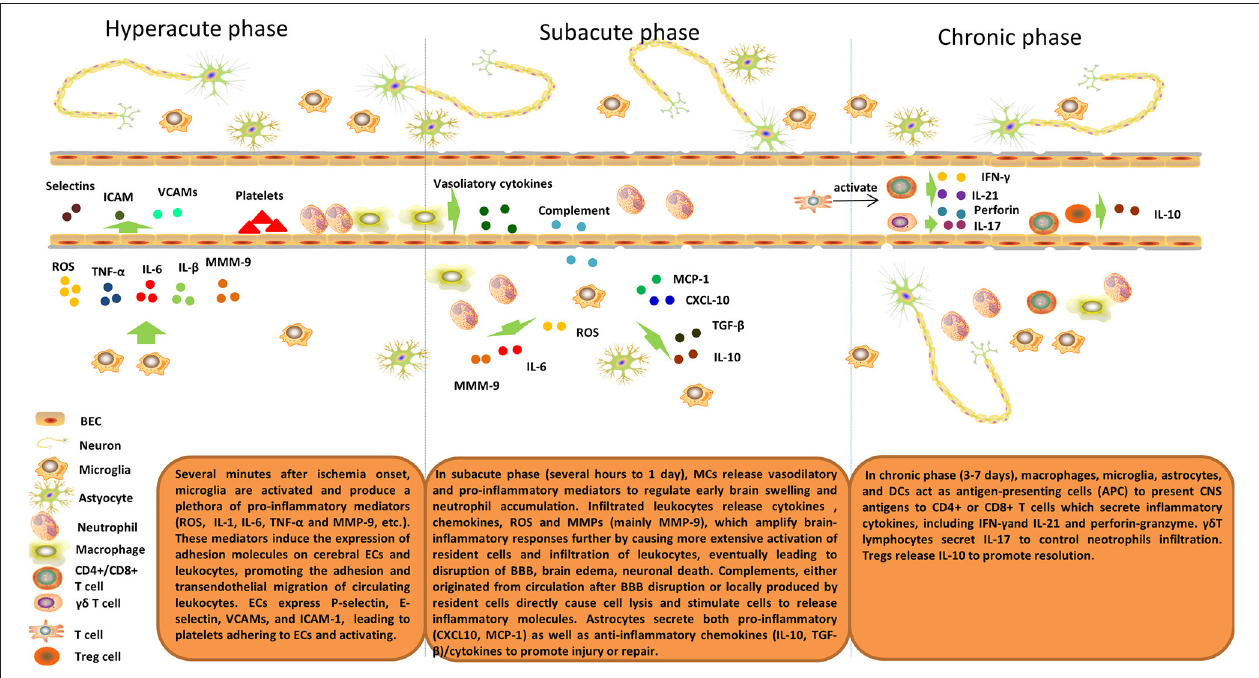
FIGURE 1 | Inflammatory response after cerebral ischemia. Brain post-ischemic inflammatory responses are characterized by innate immune activation followed by adaptive immune activation. Microglial cells are activated within minutes of ischemia onset and produce a plethora of pro-inflammatory mediators (ROS, IL-1, IL-6, TNF- α , and MMP-9, etc.). These mediators induce expression of adhesion molecules on cerebral ECs and leukocytes and, thus, promote adhesion and transendothelial migration of circulating leukocytes. ECs express P-selectin, E-selectin, VCAMs, and ICAM-1, which lead to platelets adhering to and activating ECs. In the subacute phase (hours to 1 day), MCs release vasodilatory and pro-inflammatory mediators to regulate early brain swelling and neutrophil accumulation. Infiltrating leukocytes release cytokines, chemokines, ROS and MMPs (mainly MMP-9), which amplify brain-inflammatory responses further by causing more extensive